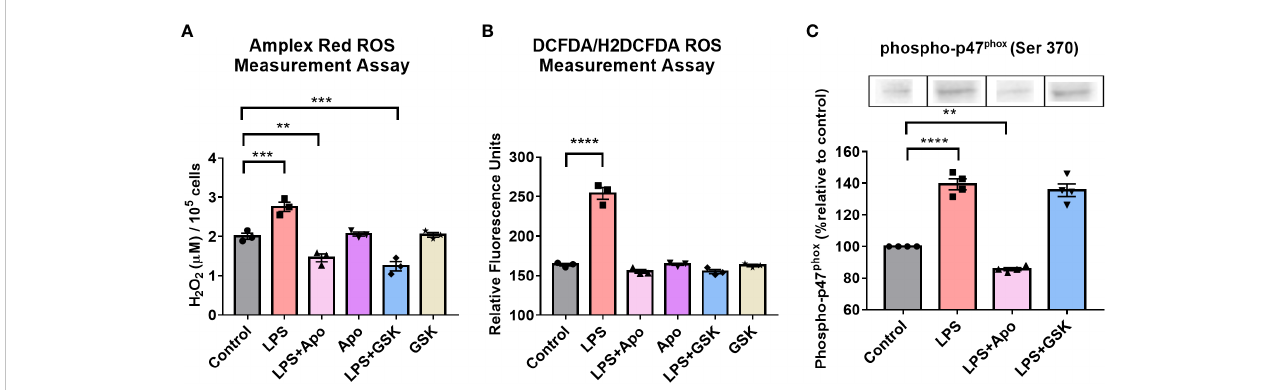
FIGURE 4 NOX2 inhibition in BV2 microglia results in the reduction of ROS levels and affects phosphorylated-p47 phox levels. ROS levels in BV2 microglia with and without LPS and, NOX2 inhibitors apocynin and GSK2795039 determined using (A) Amplex Red Assay to measure extracellular hydrogen peroxide levels and (B) DCFDA Assay to measure intracellular ROS levels. (C) Western blotting analysis of phosphorylated-p47 phox levels in BV2 microglia in the presence of LPS and NOX2 inhibitors apocynin and GSK2795039 (n = 3 to 4). For all experiments, BV2 cells with no additives were used as control sample. Data are represented as mean ± SEM and analyzed using single-factor ANOVA test. ** denotes p<0.01, **** denotes p<0.0001 and *** denotes p<0.001. For complete blot images, refer to Supplementary Information (Supplementary Figure 5).